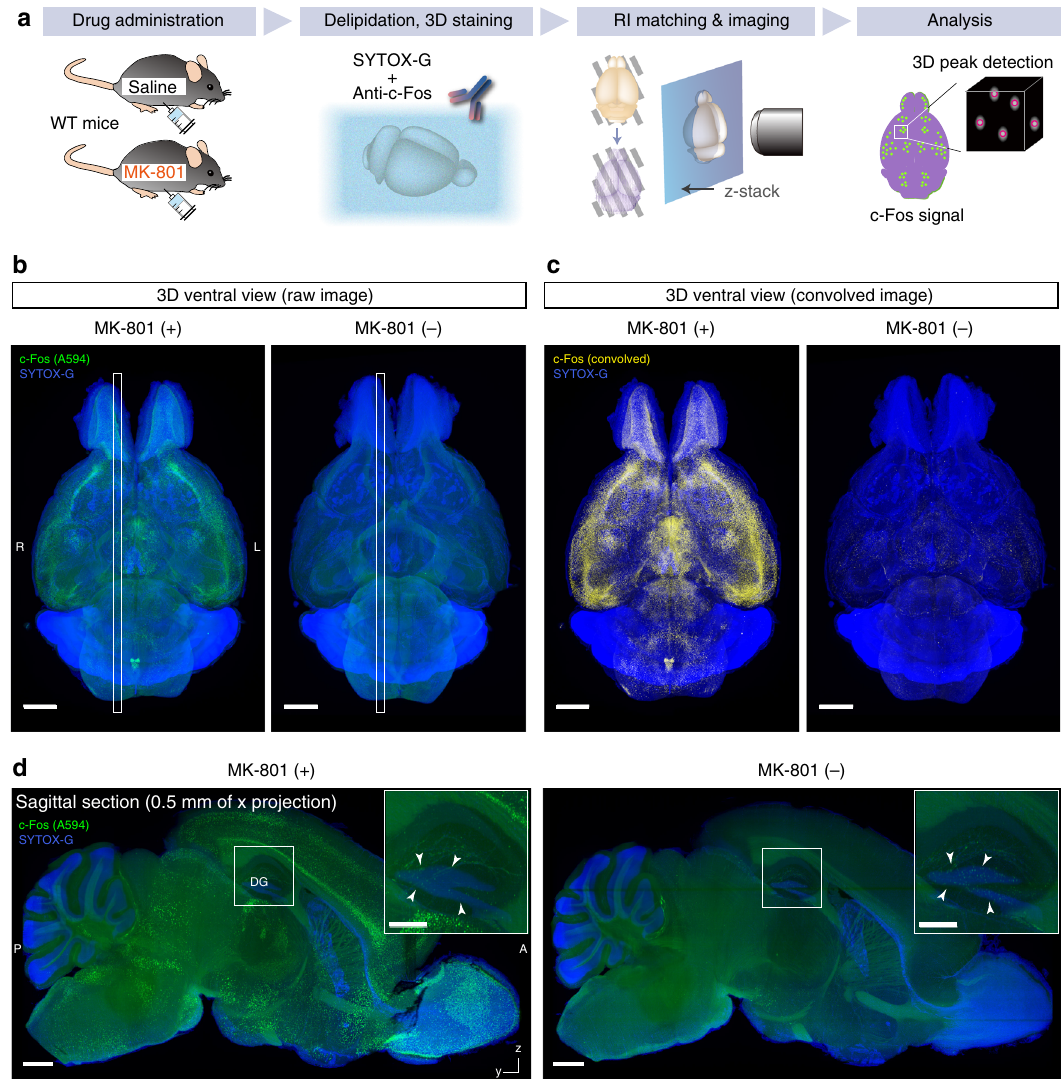
Fig. 8 CUBIC-HV allows whole-organ cellular function analysis. a Experimental schematic of whole-brain c-Fos antibody staining in different pharmacological conditions. b Whole-brain images of c-Fos-immunolabeled adult mouse brains with or without administration of NMDA receptor antagonist MK-801. The images were reconstituted with Imaris software. Voxel size 6.5 × 6.5 × 7 μ m 3 . The white box indicates the position of the reconstituted sagittal image in d . Scale: 2 mm. c Resulting images following application of a convolution fi lter to the images in b . Scale: 2 mm. d Reconstituted sagittal images of brains in b , showing uniform labeling of c-Fos-expressing cells. The c-Fos-expressing cells of the dentate gyrus (DG) region were more obvious in the MK-801 ( − ) sample (arrowheads in insets). Scale: 1 mm (whole sagittal image) and 0.5 mm